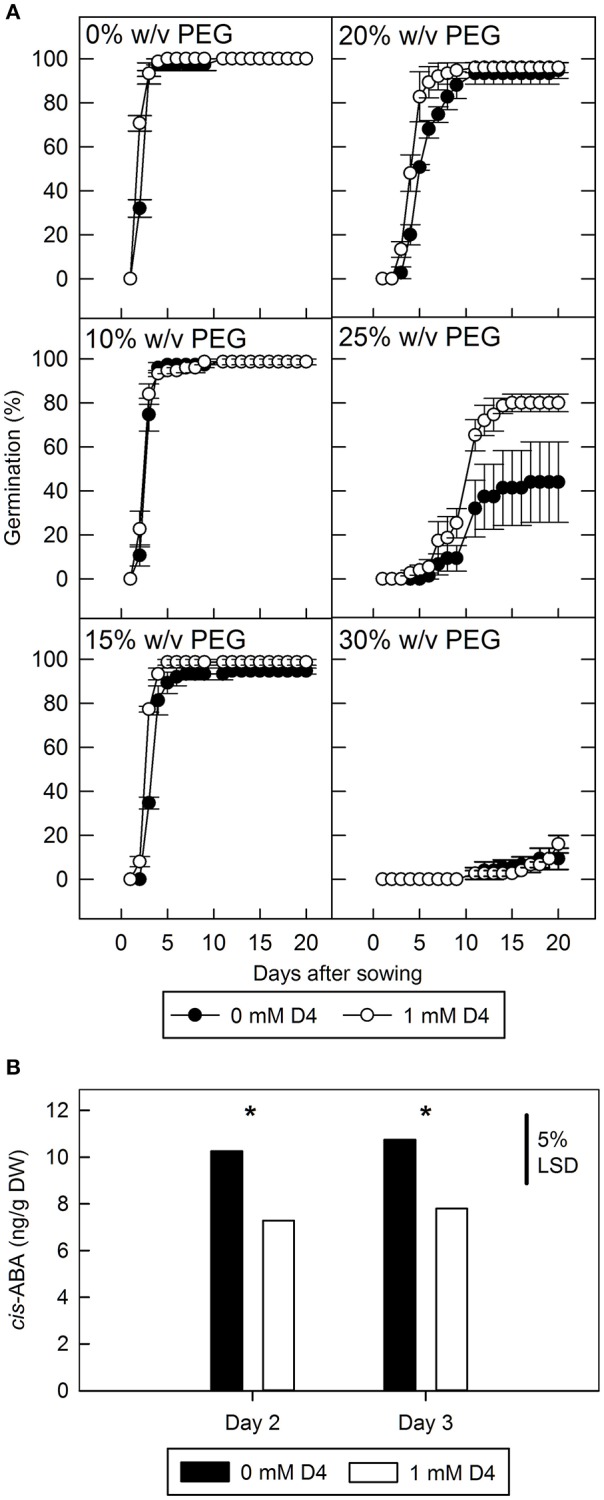
The effect of polyethylene glycol (PEG) on tomato seed germination and abscisic acid (ABA) accumulation with and without D4. (A) wild type tomato seed were imbibed on 0–30% w/v PEG with and without 1 mM D4, and radicle emergence was scored. Bars indicate standard error (n = 3). (B), cis-abscisic acid was measured in ungerminated seed imbibed in 25% w/v PEG for 2 or 3 days with or without D4. LSD at the 5% level is indicated, and *indicates a significant difference between 0 and 1 mM D4 treatments within each day (p < 0.05).